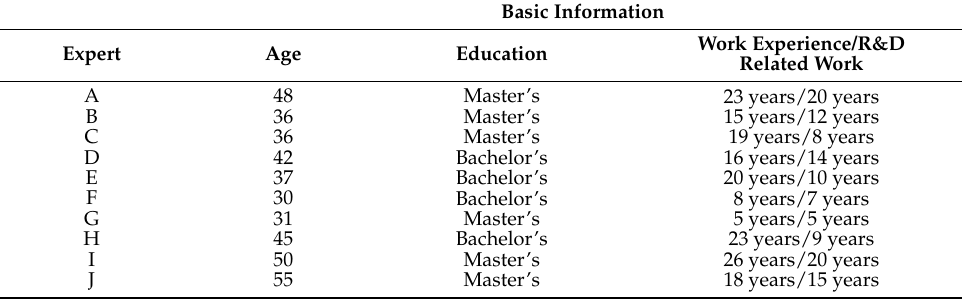
Table 4. Expert personnel’s study and experience statistics.